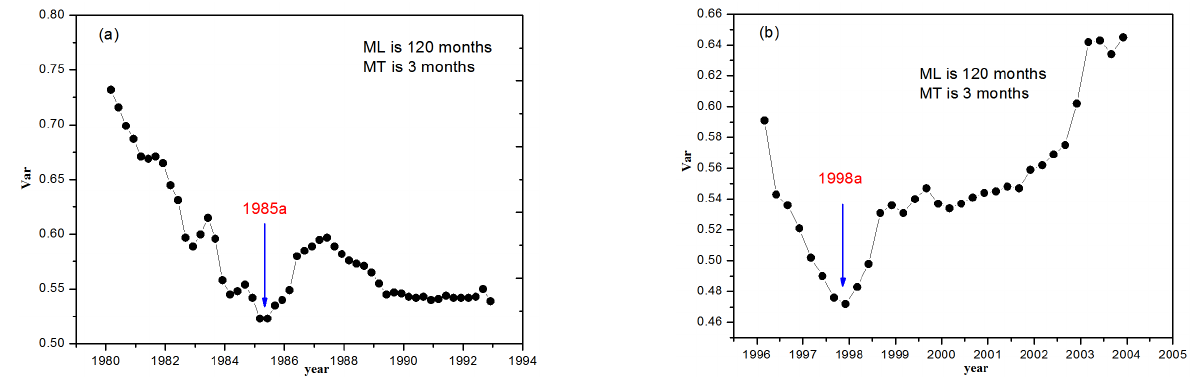
Figure 7. Variance signal-based detection for abrupt changes in ( a ) 1993 and ( b ) 2003 in the SPI sequence over the Dongting Lake basin.